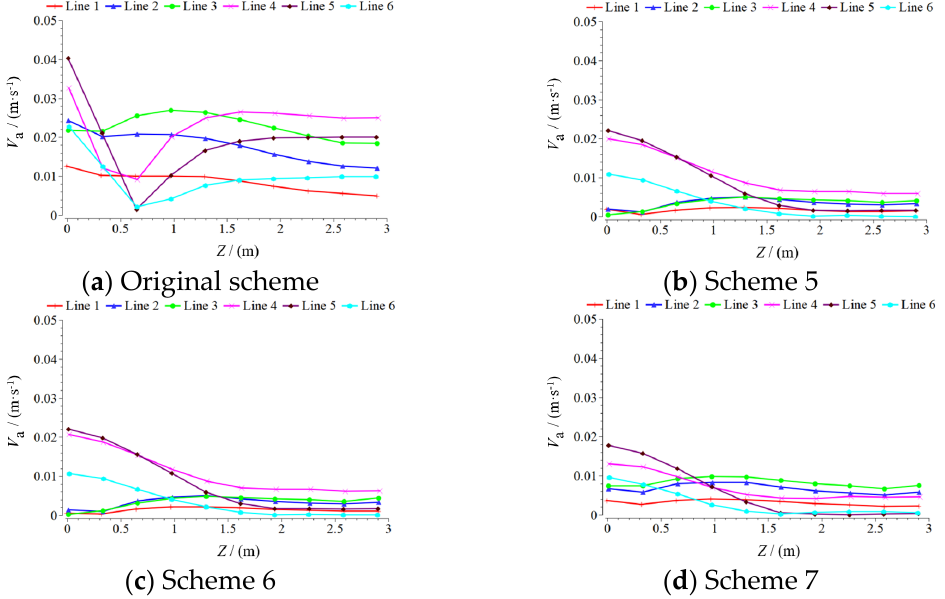
Figure 17. Diagram of axial velocity before the bell mouth in the sump 1#.